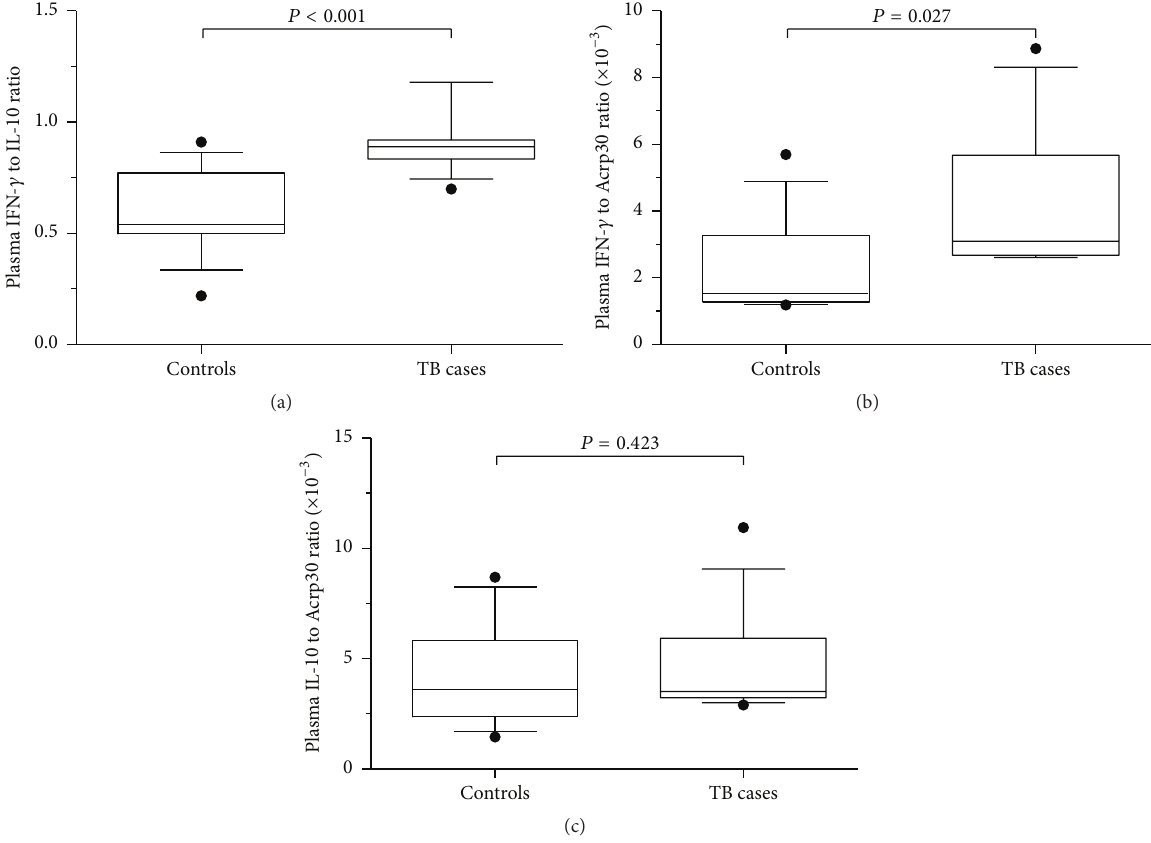
Figure 2: Circulating cytokine ratios in new tuberculosis (TB) cases ( 𝑛 = 13 ) and controls ( 𝑛 = 14 ). (a) Circulating interferon-gamma (IFN- 𝛾 ) to interleukin-10 (IL-10) ratio in TB cases and controls. (b) Circulating IFN- 𝛾 to adiponectin (Acrp30) ratio in new TB cases and controls. (c) Circulating IL-10 to adiponectin (Acrp30) ratio in new TB cases and controls. Data are presented as box plots, where the box represents the interquartile range, the line through the box represents the median, whiskers indicate the 10th and 90th percentiles, and the closed circles represent outliers. Statistical comparisons were performed using the Mann-Whitney 𝑈 test. IFN- 𝛾 to IL-10 ratios were higher in the TB cases relative to controls ( 𝑃 < 0.001 ). IFN- 𝛾 to adiponectin ratios were also increased in TB cases relative to controls ( 𝑃 = 0.027 ). IL-10 to adiponectin ratios were similar in TB cases relative to controls ( 𝑃 = 0.423